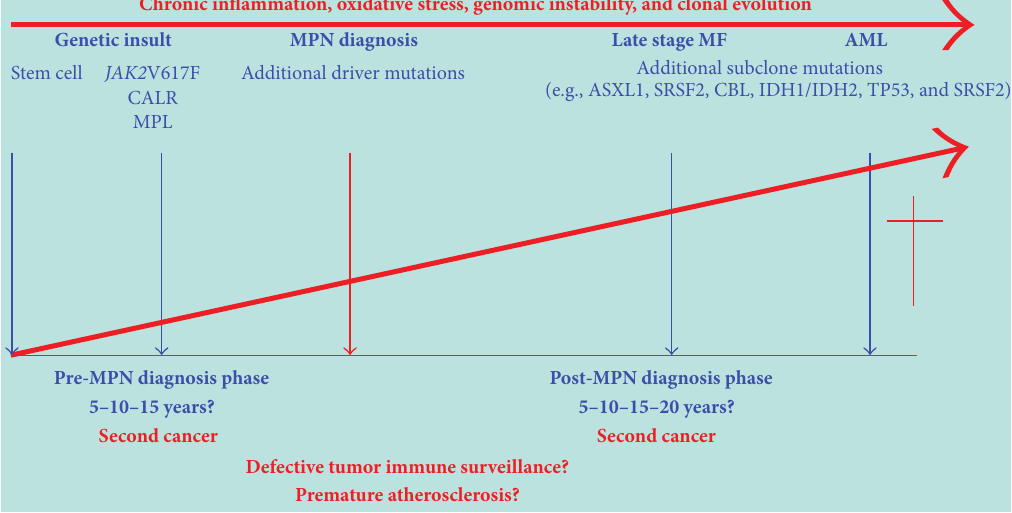
Figure 4: Patients with MPNs have an increased risk of second cancer not only after the MPNs diagnosis but also in the pre-MPNs diagnosis phase, which may last several years in which the patients are at an increased risk of severe cardiovascular and thromboembolic events. According to this model, the initial stem cell insult has occurred 5–10–15 years before the MPNs